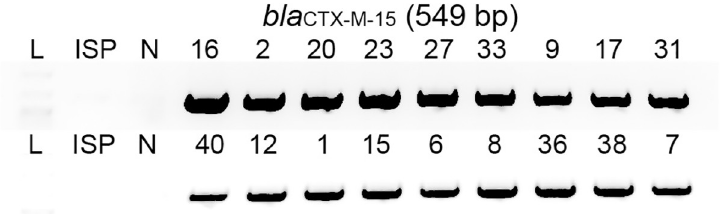
Fig 4. Molecular basis of third-generation cephalosporin-resistance among XDR S . Typhi isolates. PCR reactions for bla CTX-M-15 . ISP, antibiotic-susceptible S . Typhi ISP2825. N, negative control containing all PCR components except for S . Typhi genomic DNA. Note that all XDR S . Typhi isolates are resistant to cephalosporin.